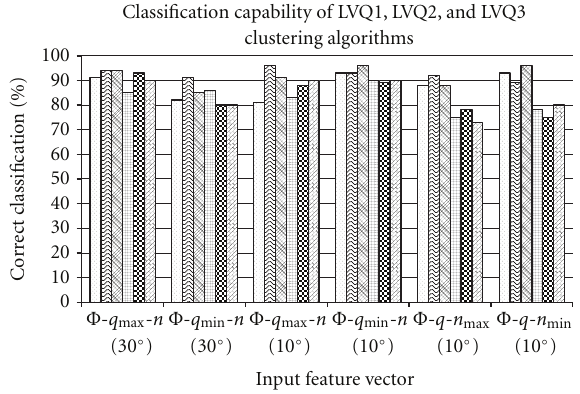
Figure 17: Classification capability of OPNN and APNN with six types of feature inputs with 4- and 5-types of overlapped patterns— with LVQ clustering algorithms (in the histogram dotted, chequered blocks refer to 4- and 5-type inputs to PNN; striped and brick blocks refer to 4- and 5-type inputs to